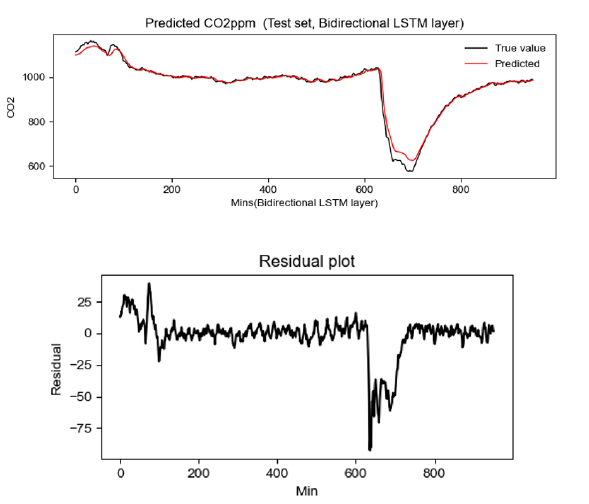
Figure 7. Results of the overall prediction and residual